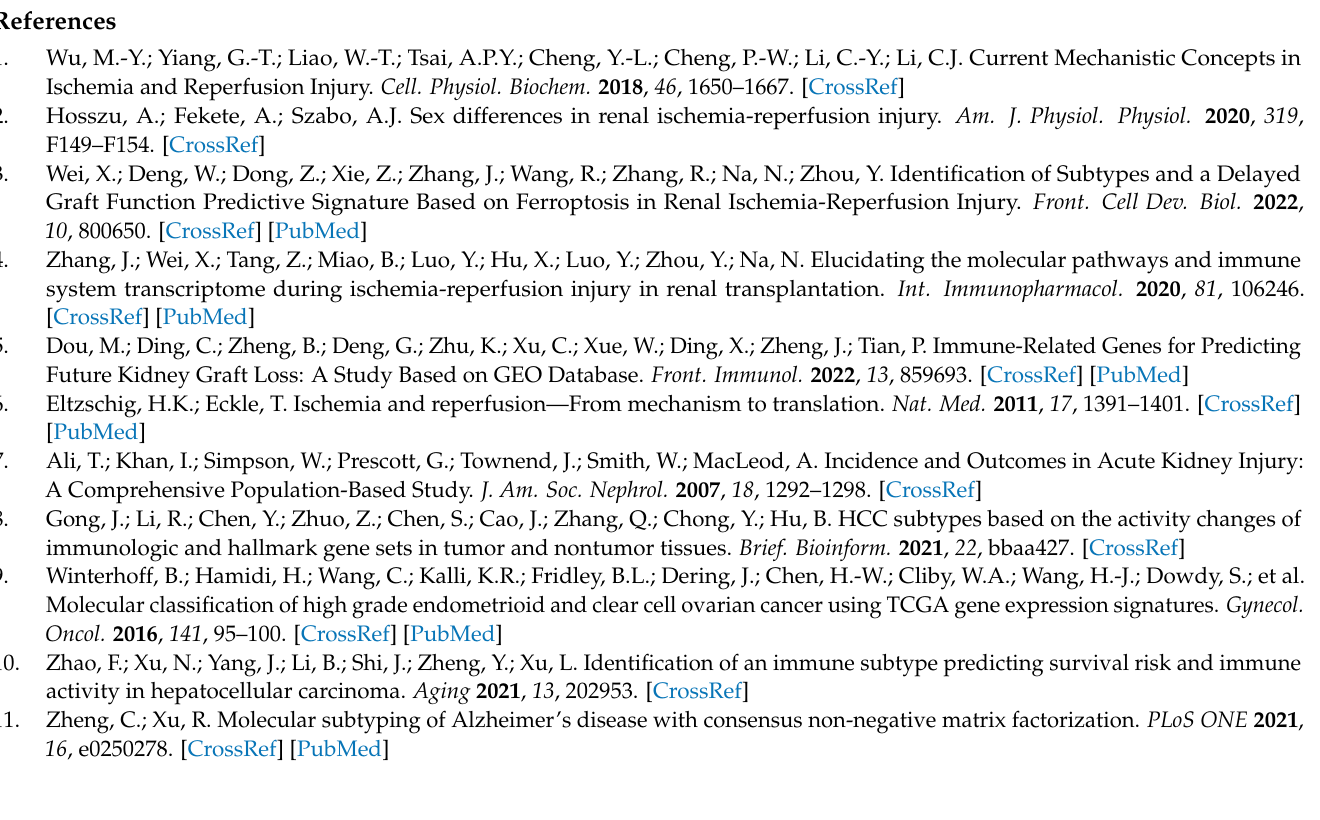
visualization scatter plots of different cluster numbers (2 to 5) obtained using the t-sne dimensionality reduction algorithm. (I) is the line plot of the contour coefficient change as the number of clusters increases; Figure S3: The results obtained by the NMF algorithm under the best parameters for different cluster numbers. (A–D) are 2D visualized scatter plots of other cluster numbers (2 to 5) obtained using the PCA dimensionality reduction algorithm. (E–H) are 3D visualization scatter plots of different cluster numbers (2 to 5) obtained using the PCA dimensionality reduction algorithm. (I) is the line plot of the contour coefficient change as the number of clusters increases; Figure S4: The results obtained by the K-means algorithm under the best parameters for different cluster numbers. (A–D) are 2D visualized scatter plots of other cluster numbers (2 to 5) obtained using the PCA dimensionality reduction algorithm. (E–H) are 3D visualization scatter plots of different cluster numbers (2 to 5) obtained using the PCA dimensionality reduction algorithm. (I) is the line plot of the contour coefficient change as the number of clusters increases; Figure S5: Comparison of the contour coefficients of the three algorithms. (A–C) show the line plots of the contour coefficients of NMF, K-means and DL-ONMF as the number of clusters,